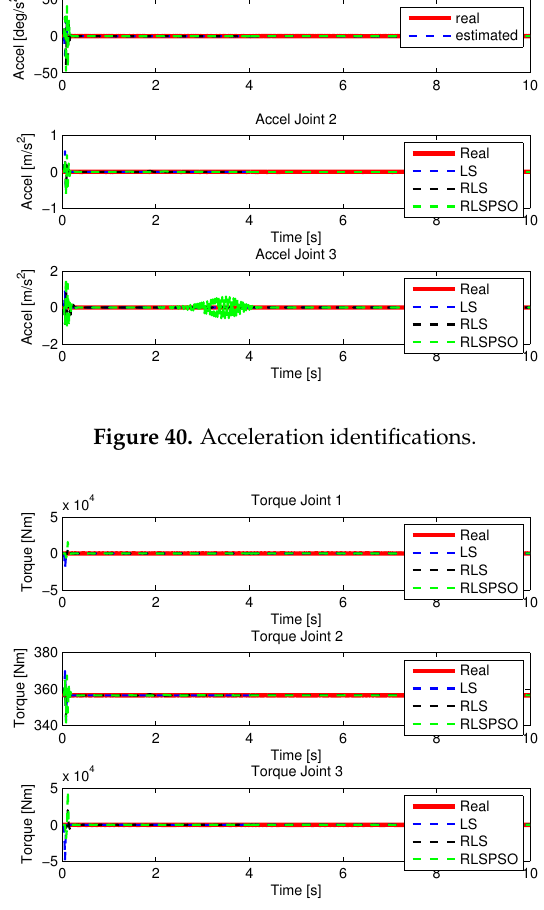
Figure 41. Torque